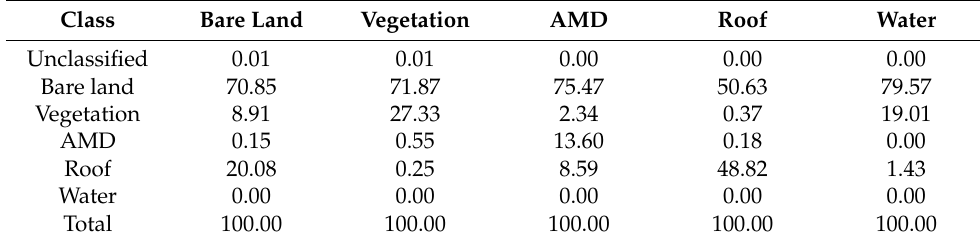
Table 3. The confusion matrix of the SVM results (%).